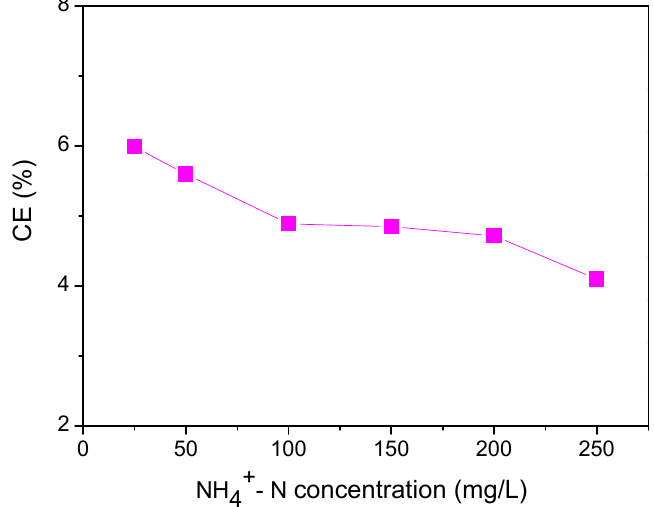
Figure 5. Change in CE with increasing influent concentrations.